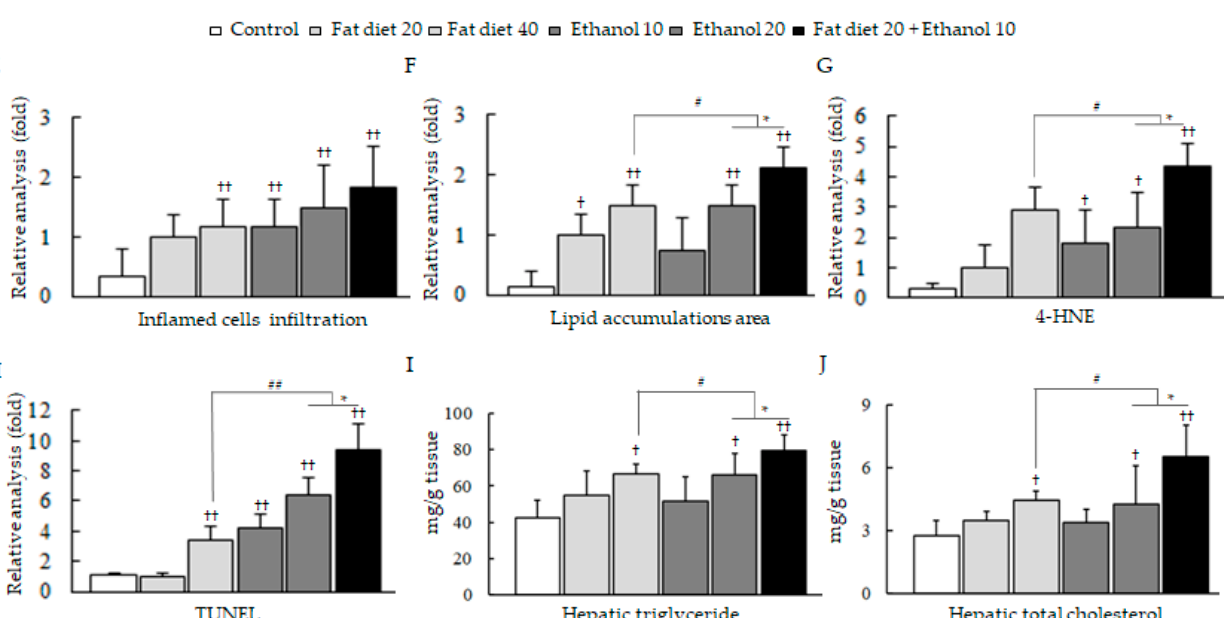
Figure 1. Histopathological analyses and hepatic lipid profiles. Representative photomicrographs of liver tissues for hematoxylin and eosin (H&E) staining ( A ), oil red O staining ( B ), immunohistochemistry (IHC) for 4-hydroxy-2-nonenal (4-HNE) ( C ) and terminal deoxynucleotidyl transferase dUTP nick end labeling (TUNEL) ( D ) and their quantitative analyses for inflammatory cell infiltrations ( E ), lipid droplets areas ( F ), intensity or cell count of positive cells ( G , H ), fold change comparing to fat diet 20 group are presented. Triglyceride ( I ) and total cholesterol ( J ) levels in hepatic tissue. Data are expressed as the mean ± SD ( n = 6). † p < 0.05 and †† p < 0.01 compared with the control group; # p < 0.05 and ## p < 0.01 compared with the fat diet 40 group; * p < 0.05 compared with the ethanol 20 group. The photograph was obtained using a light or fluorescence microscope ( ×